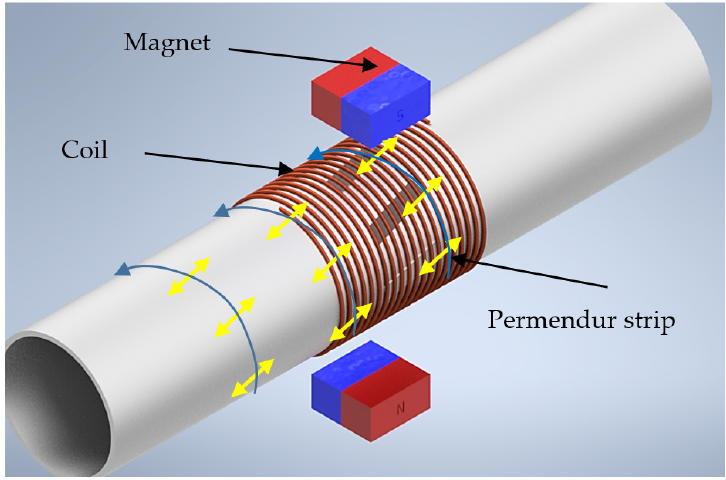
Figure 1. Magnetostrictive transducer (EMAT).